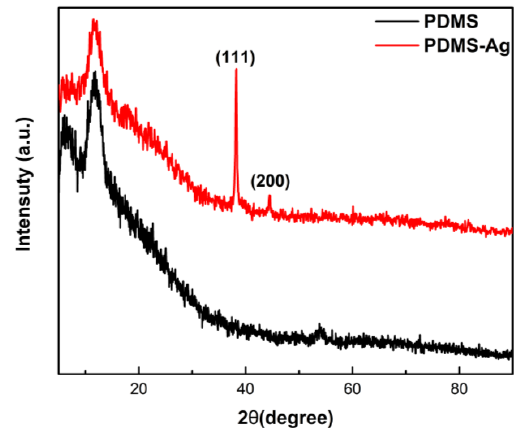
Figure 1. XRD spectra of the PDMS-BWS substrate before and after Ag deposition by thermal evap-